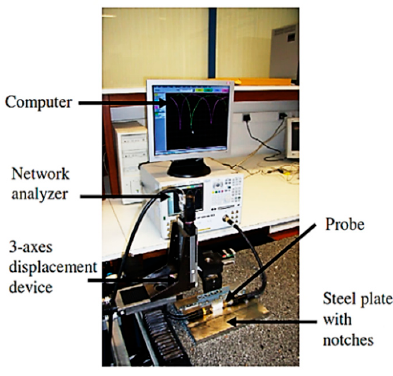
Figure 3. Photograph of the experimental setup (from [29]; copyright © 2008; reproduced with permission).